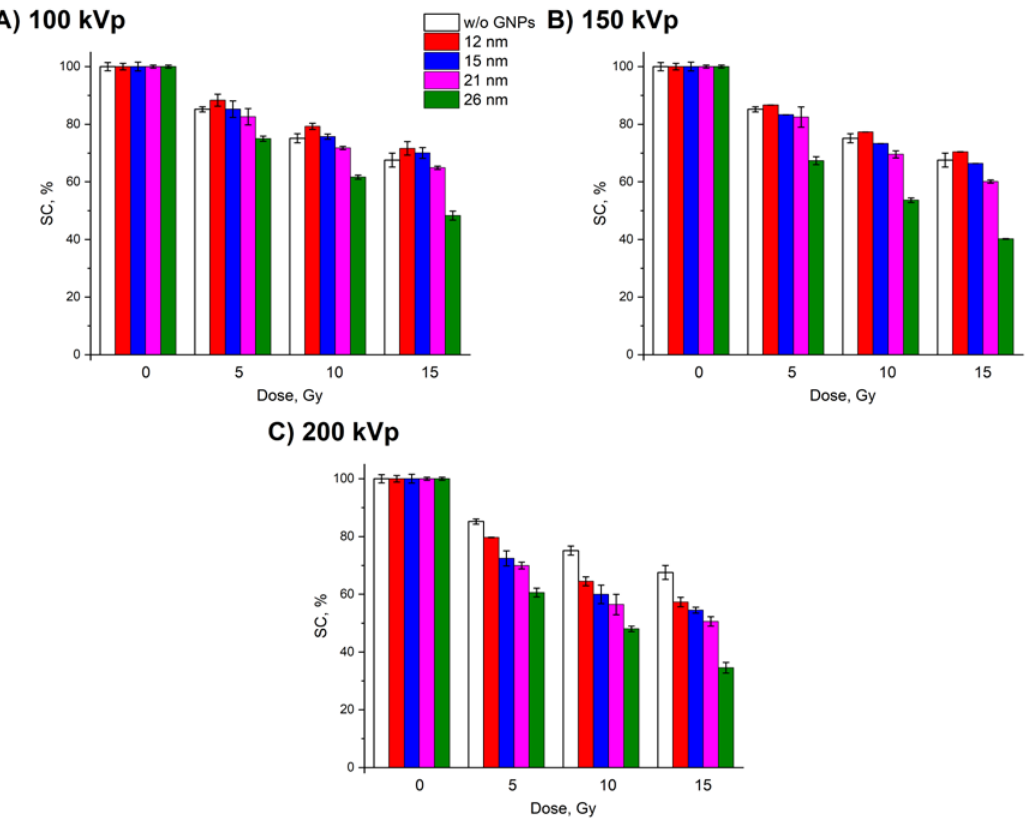
Figure 8. Effect of the X-ray tube voltage on the amount of SC DNA (relative to control samples): 100 kVp ( A ), 150 kVp ( B ), and 200 kVp ( C ). No GNPs (white). 2.4 mg/mL GNPs with a size of 12 nm (red), 15 nm (blue), 21 nm (magenta), and 26 nm (green). The GNP:DNA ratios in the samples were 15.3 (12 nm), 7.8 (15 nm), 2.8 (21 nm), and 1.5 (26 nm) particles per one DNA molecule. Error bars are mean confidence intervals calculated by three parallel independent measurements for α = 0.05.